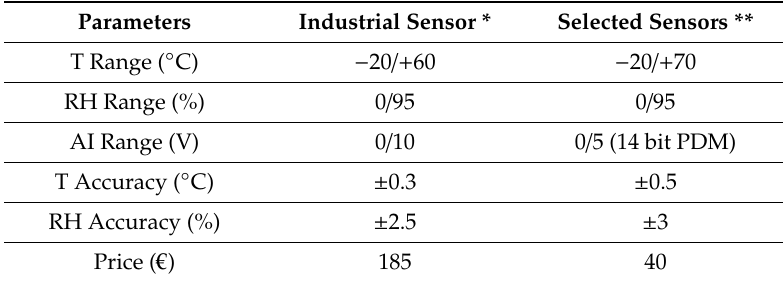
Table 2. Summary of the main features of industrial-standard sensors and the selected